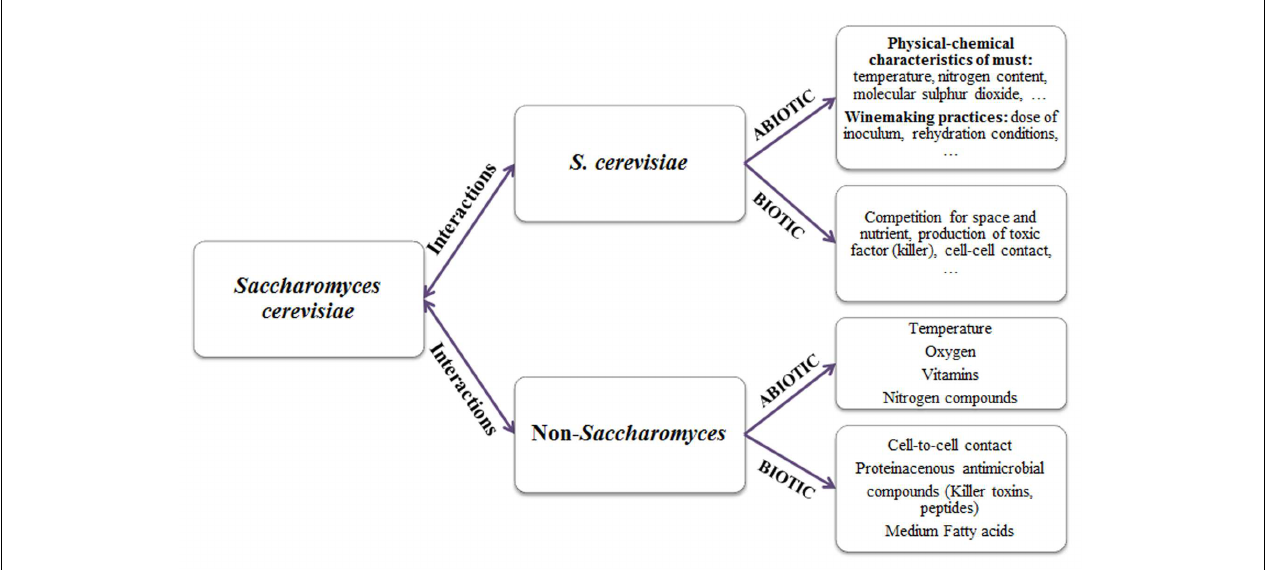
FIGURE 1 | Factors affecting yeast interactions in inoculated wine